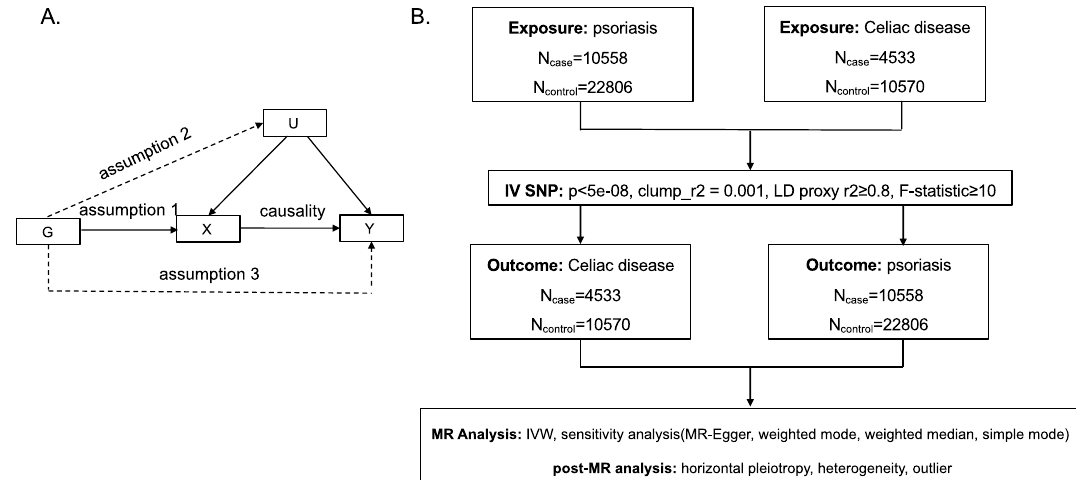
Figure 1. ( A ) Schematic diagram of the hypothetical relationship between genetic variant (G), exposure (X), and outcome (Y), in the presence of unobserved confounding factors (U). Solid arrows represent allowed associations between the variables, while dashed lines represent associations that are needed to be avoided for G to qualify as a robust instrumental variable (IV). ( B ) Diagram of the process for the bidirectional 2-sample MR